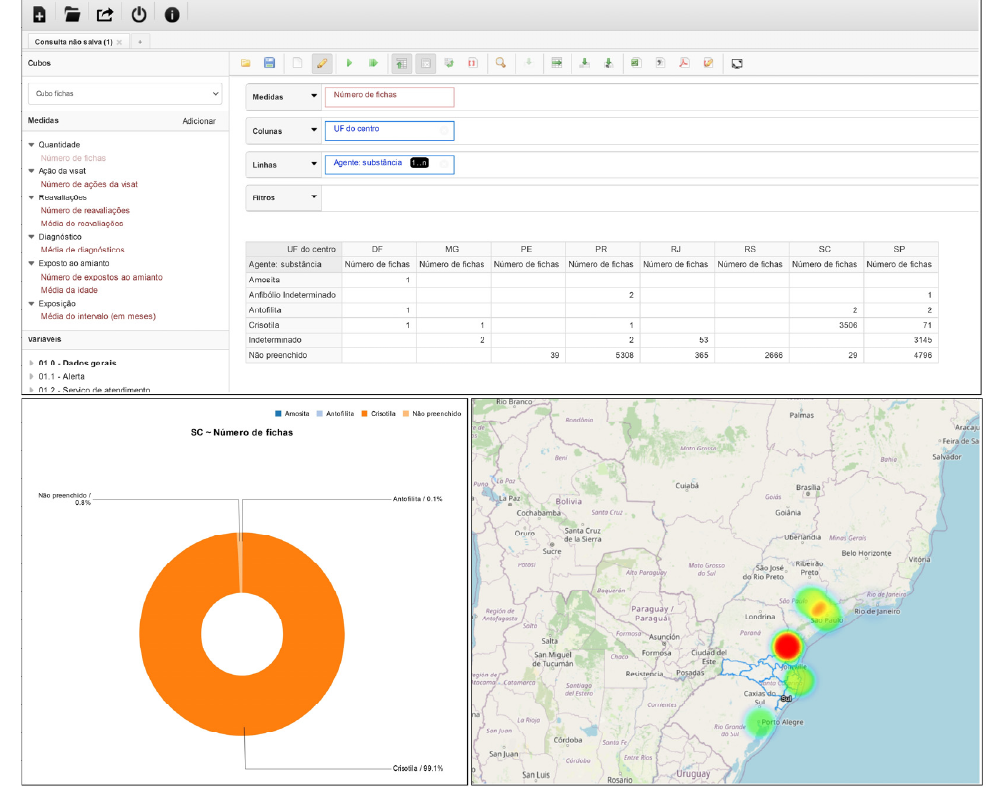
Figure 4. Output examples from the Datamianto system’s BI module. Notes: dynamic table of cases registered by each State, by exposure agent ( top ); chart displaying epidemiological data ( bottom left ); georeferenced heat map for registered cases by municipality/region, in which darker colors indicate more registered cases ( bottom right ). Source: Datamianto system, Brazil, 2022.